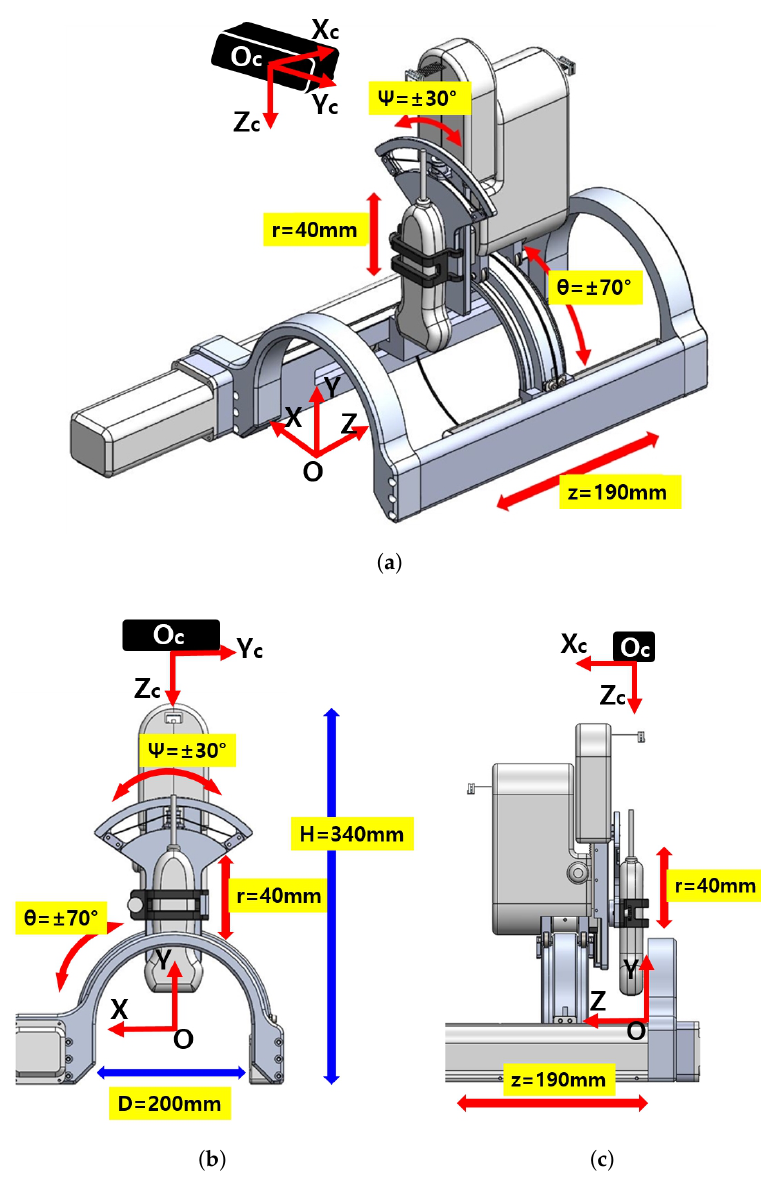
Figure 1. Overview of the developed 4 degrees of freedom (DOF) sarcopenia detection system. ( a ) Perspective view. ( b ) Front view. ( c ) Side